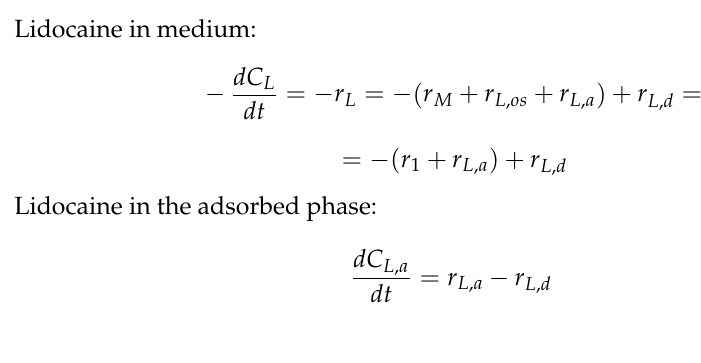
Figure 2. Scheme of metabolic and physical transformations, the kinetics of which was considered in the models proposed: La—adsorbed lidocaine; LB—protein-bound lidocaine; Lu—unbound lidocaine; M—MEGX; os—species other than MEGX formed from lidocaine; P—products formed from